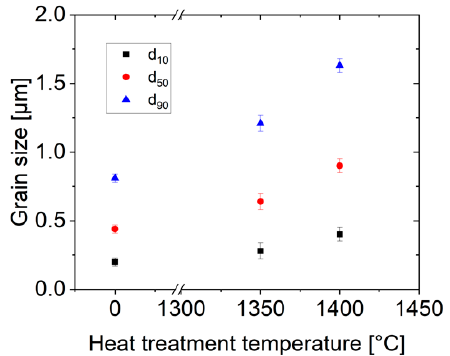
Figure 4. Overlay of Mg distribution (EDX, violet color) and electron image of the polished cross section of the sample: ( a ) O1; ( b ) HT1400 (different magnifications were used due to the different grain sizes of the samples).